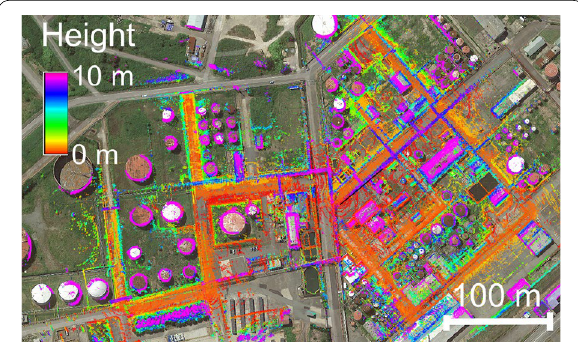
Fig. 13 3D map built from FS 1.0 based on GPS and LIDAR (consist- ency with the aerial map): 3D point cloud with correct building shapes and 3D point cloud positions aligned with the aerial map